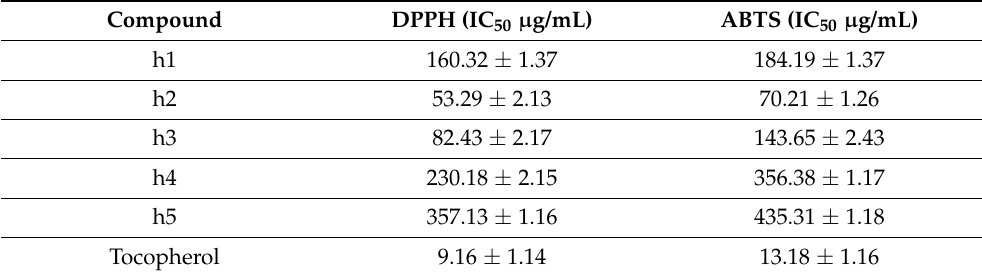
Table 1. In vitro antioxidant activity of mono-carbonyl curcumin analogues ( h1 – h5 ).